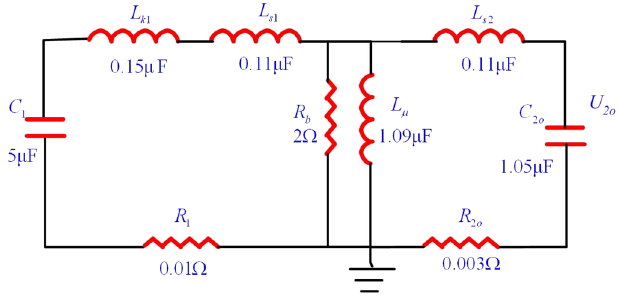
FIG. 9. Equivalent schematics used in the circuit simulation